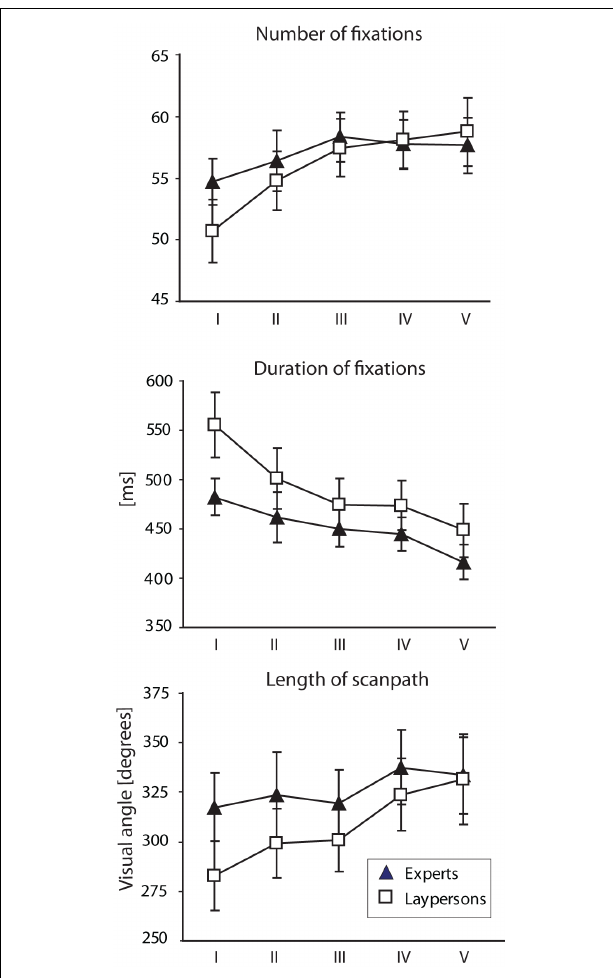
FIGURE 3 | Gaze patterns relative to the abstraction level of the paintings for Part 2 (all 30s). Average number of fixations (top row), mean duration of fixations (mid row), and total length of the scanpath (bottom row) for experts and laypersons.The error bars represent